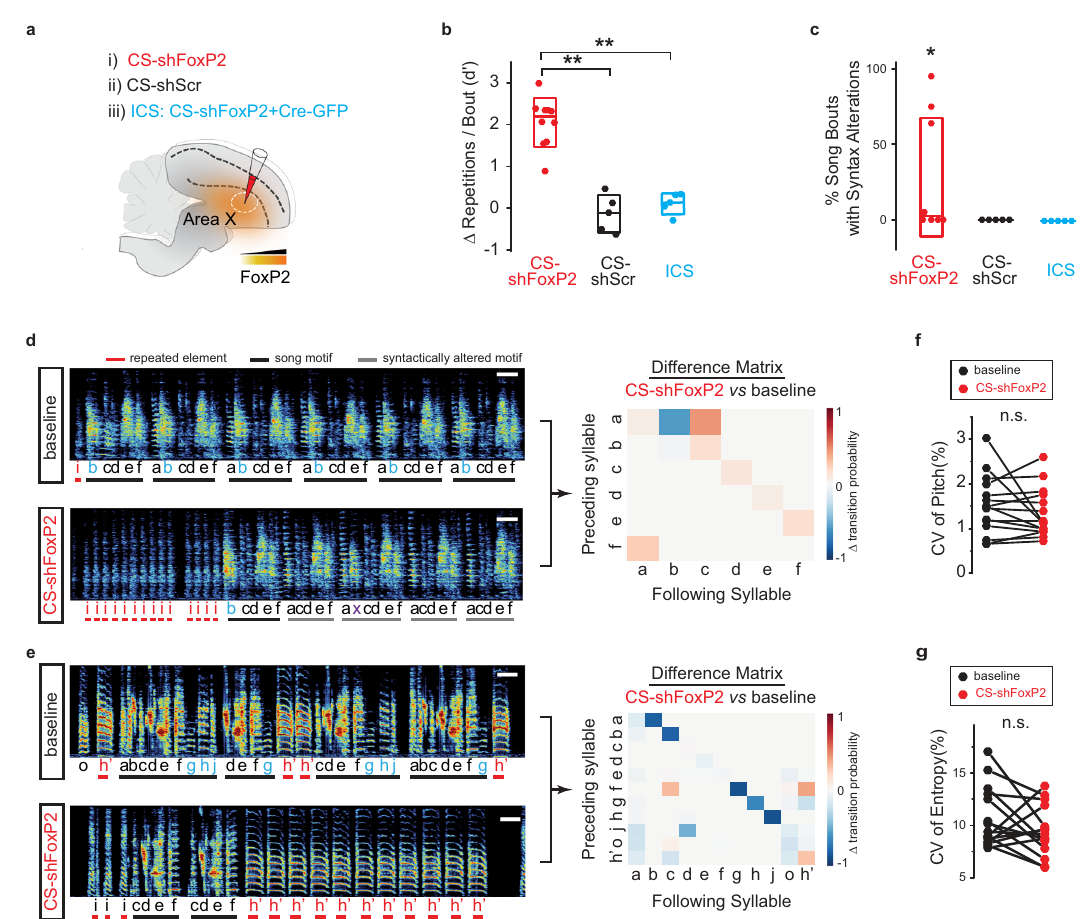
Fig. 2 FoxP2 Knockdown disrupts syllable sequencing and repetition in adulthood. a CS constructs were bilaterally injected into Area X of adult birds, alone (i, CS-shFoxP2; ii, CS-shScr) or with Cre-GFP (iii, CS-shFoxP2/Cre-GFP, termed Inverted Cre-Switch (ICS)). b Changes in the number of vocal repeats per song bout for CS-shFoxP2 + birds ( d ′ = 2.05±0.41[mean±SEM], n = 8 birds), CS-shScr + birds ( d ′ = − 0.13±0.56[mean±SEM], n = 5 birds), and ICS + birds (blue circles, d ′ = 0.11±0.31[mean±SEM], n = 5 birds). Repetition changes in CS-ShFoxP2 + birds were signi fi cantly greater than CS-shScr + and ICS + birds (2 months post injection vs baseline, CS-shScr, p = 0.0023; ICS, p = 0.015, Kruskal – Wallis test). Box indicates the median±SD. c % syntax alterations for CS- shFoxP2 + birds ( n = 8 birds), CS-shScr + birds ( n = 5 birds), and ICS + birds ( n = 5 birds) 2 months post injection. Syntax alterations was signi fi cantly greater than zero in CS-ShFoxP2 + birds ( p = 0.02, one tailed one sample t test). Box indicates the median±SD. d Left panel: song recorded at baseline and 2 months after bilateral injection of CS-shFoxP2 in Area X of an adult bird. The number of repetitions of introductory elements ‘ i ’ (red) in each song bout were increased and syllable ‘ b ’ (blue) was omitted in a subset of motifs. Each letter indicates an individual syllable. Scale bar, 200ms. Right panel: difference transition matrices. Subtracting the syllable transition matrix at 2 months following CS-shFoxP2 injection from the matrix at baseline reveals changes in the syllable transitions following FoxP2 knockdown. e Left panel: song recorded from a second bird at baseline and 2 months after bilateral injection of CS-shFoxP2 in Area X. The number of repetitions of syllable ‘ h ” (red) increased and other vocal elements (syllables ‘ g ’ , ‘ h ’ , and ‘ j ’ , blue) were omitted. Syllable ‘ h ” is considered a variant of syllable ‘ h ’ . Scale bar, 200ms. Right panel: difference transition matrices. f Variability of syllable pitch at baseline (CV = 1.52±0.17%[mean±SEM]) and two months post injection of CS-shFoxP2 + birds (CV = 1.34±0.14%[mean±SEM]; p = 0.75, n = 15, Wilcoxon signed-rank test). g Variability of syllable entropy at baseline (CV = 10.7±0. 75%[mean±SEM]) and two months post injection of CS-shFoxP2(CV = 9.46±0.62%[mean±SEM]; p = 0.17, n = 15, Wilcoxon signed-rank